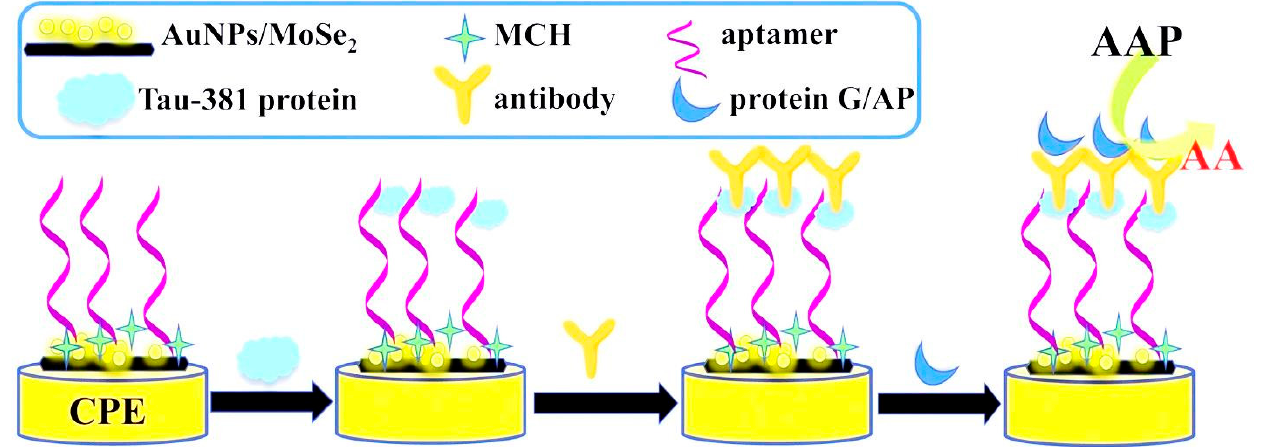
Figure 5. Schematic representation of an enzyme-linked aptamer photoelectrochemical aptasensor for Tau-381 protein. Reprinted from [44] with permission.